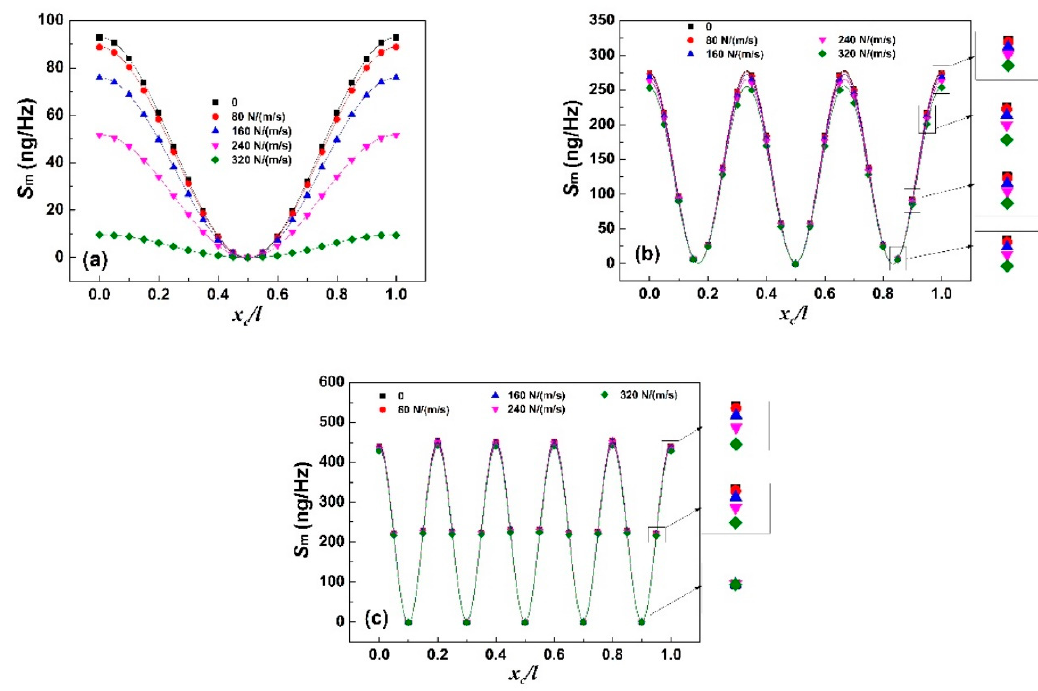
Figure 3. S m as the function of target loading position in the liquids with different viscous damping coefficient under: ( a ) first-order resonance; ( b ) third-order resonance; and ( c ) fifth-order resonance.